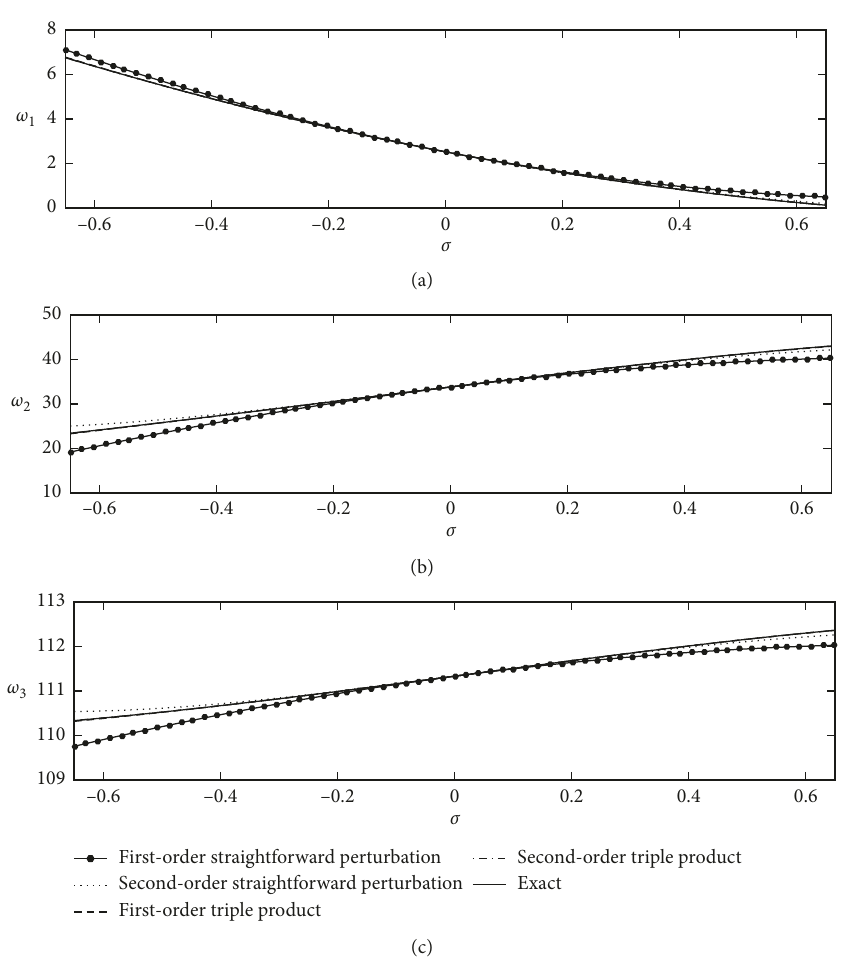
Figure 2: The exact and approximate natural frequencies (rad/s) of the torque-free rigid body as a function of σ